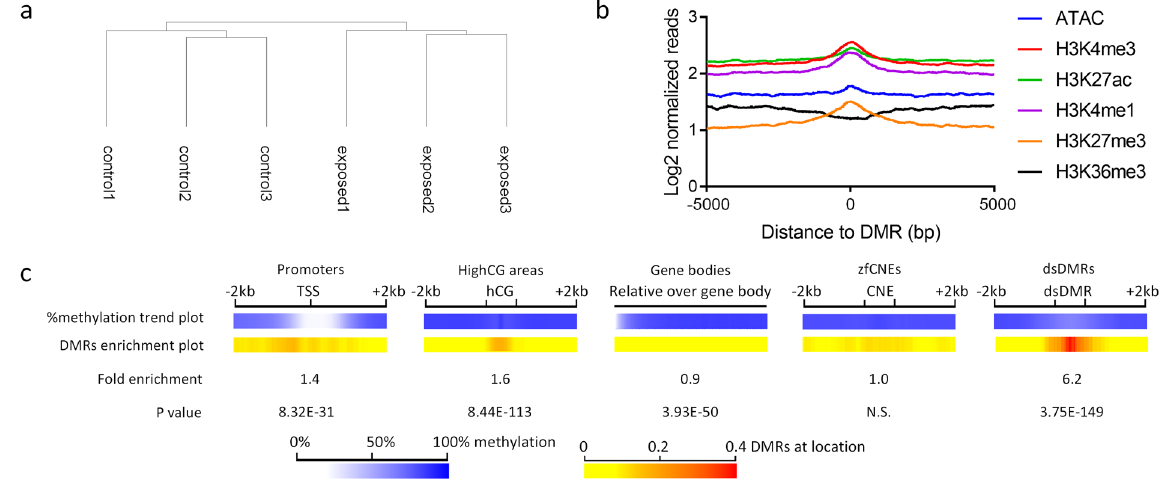
Figure 2. Distribution of DNA methylation and differentially methylation regions (DMRs) over specific features. ( a ) Cluster analysis of all measured CpG sites with at least 5 reads in all replicates (ward clustering). ( b ) Trend plot of different histone post translational modification and ATAC sequencing data surrounding DMRs ( c ) The methylation trend plot shows the percentage methylation over the specific regions, the DMR enrichment plot show the locational preference for DMRs over certain regions. The fold enrichment and P value show the enrichment of DMRs on the specific region over the total amount of measured regions (hypergeometric test). zfCNE: zebrafish non-genic element; dsDMR: developmental stage specific